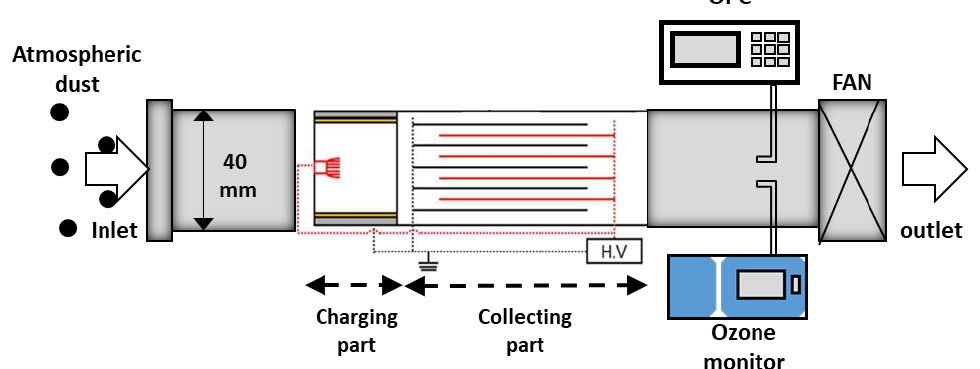
Figure 3. Experimental schematic for the single-pass PM removal efficiency test.